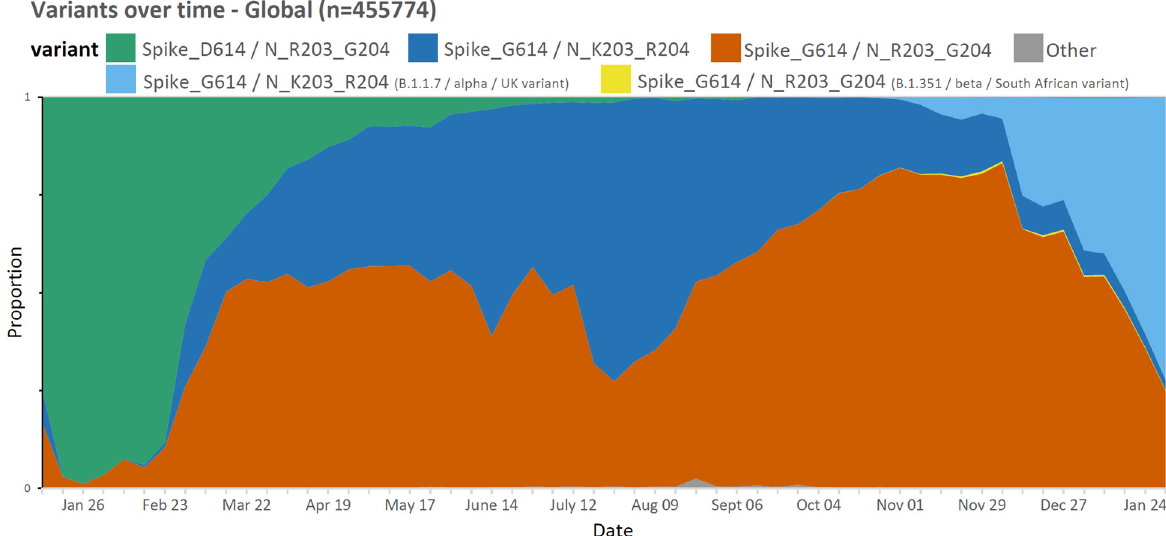
Figure 1. Proportion of weekly deposited SARS-CoV-2 sequences globally (n=455774). The D614G (B.1) variant has become one of the dominant forms globally between January 2020 and January 2021. Note a small proportion of deposited sequences did not include information regarding specific collection date and as such were